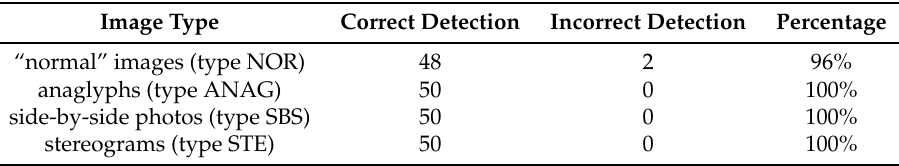
Table 5. Detection rate of our